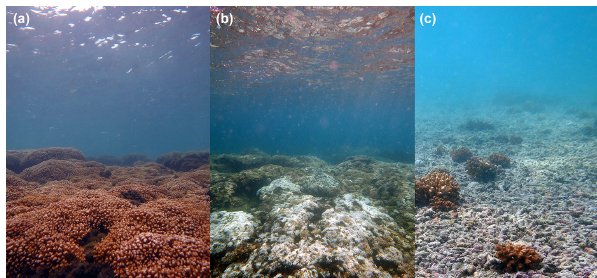
Figure 1. Photographs depicting the typical states of coral reefs in Pacific Panama (a) before, (b) during, and (c) after an El Niño event. Photograph (a) shows an example of a well developed coral reef dominated by branching Pocillopora corals. Photograph (b) shows a reef dominated by Pocillopora experiencing high levels of coral bleaching during the 2015–2016 El Niño event. Photograph (c) shows a large area of Pocillopora rubble that has persisted since the 1982–1983 El Niño